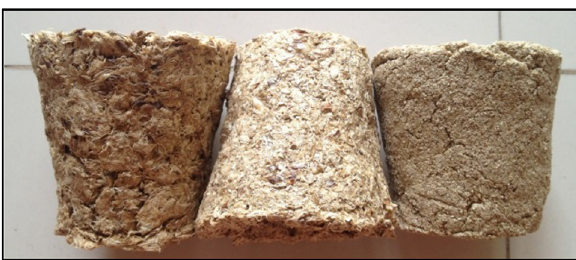
Fig. 4 Surface texture of decomposable pots, from left: coarse, medium and fine